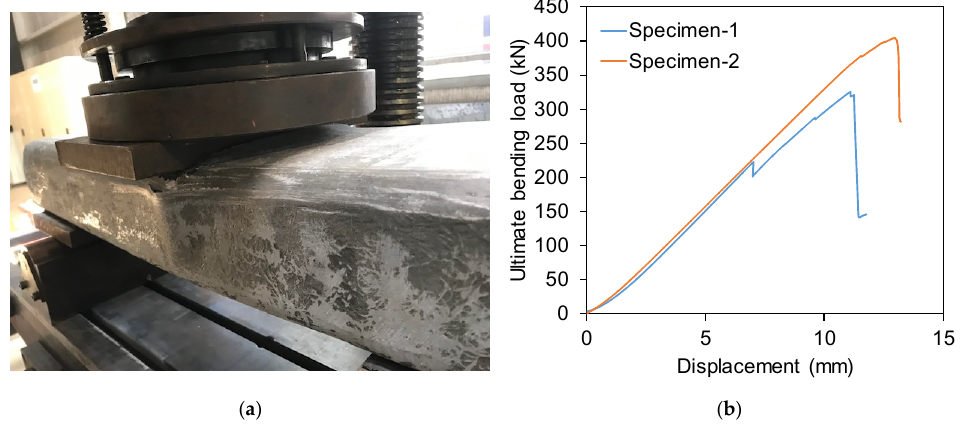
Figure 5. Ultimate test results. ( a ) Test setup and failure mode. ( b ) Load-displacement behaviour.